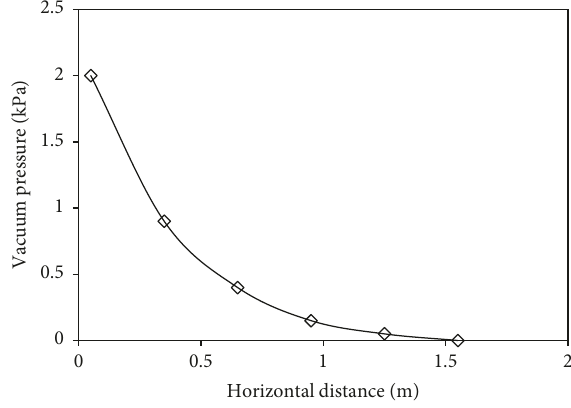
Figure 6: Distribution curve of vacuum pressure.